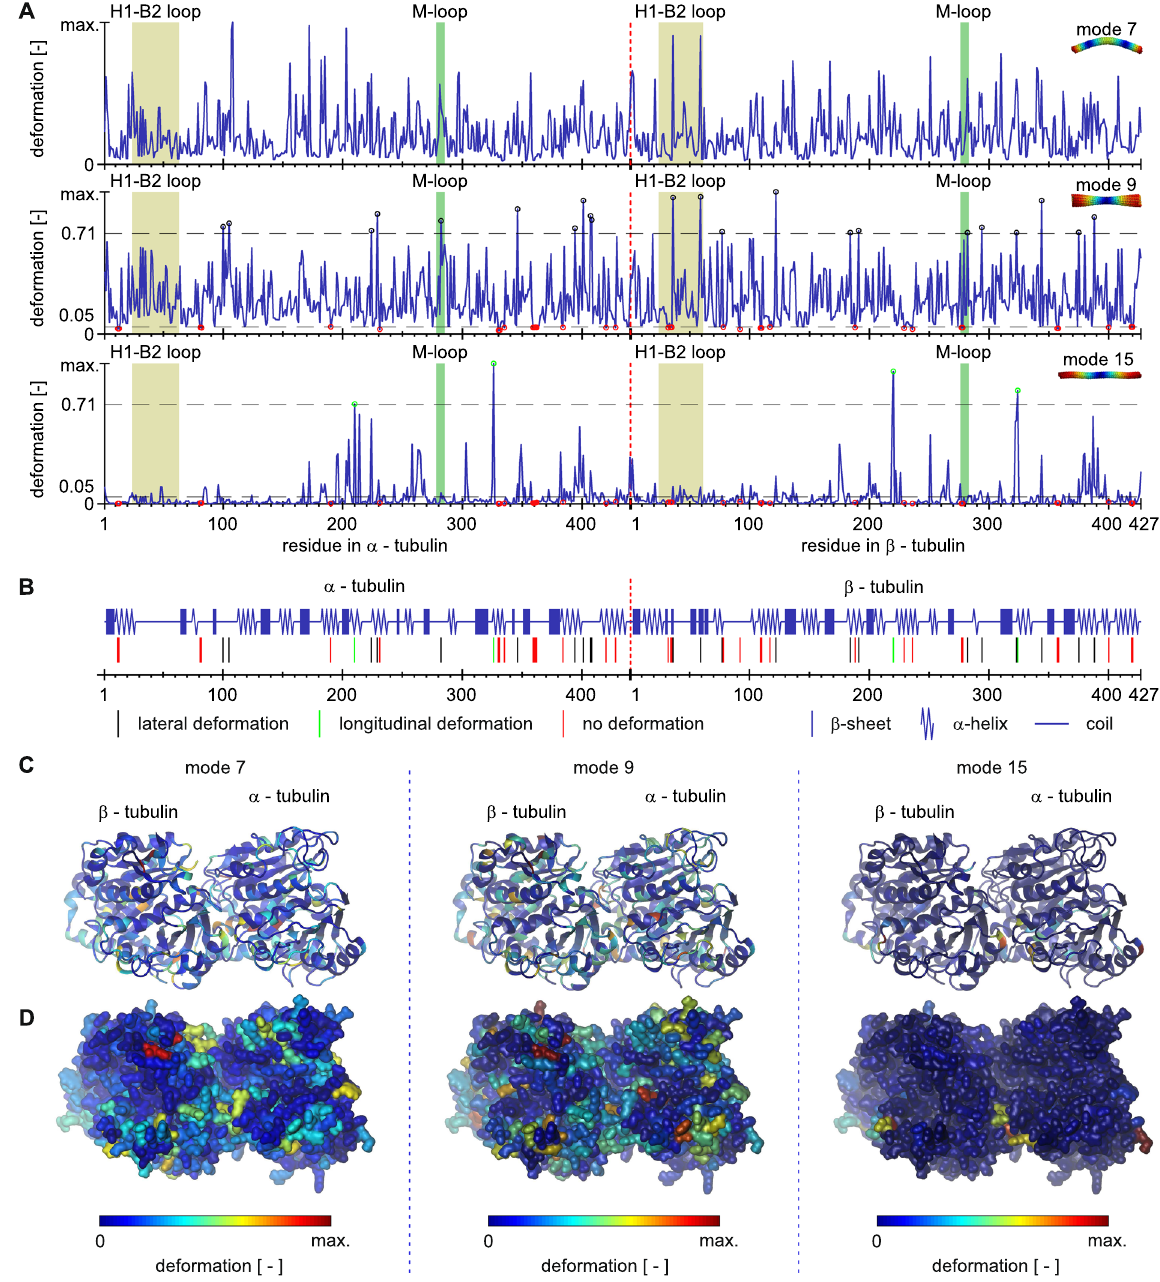
Figure 4. Average absolute value of deformation in tubulin dimers for three principal shapes of normal modes. ( A ) detailed view for the data shown in Fig. 3C. The average absolute deformation along tubulin dimer sequence is shown in blue. ( B ) specific regions of the sequence with substantial deformation are indicated in the secondary structure of tubulin dimer. They are also indicated with circles of respective color in ( A ), together with criterion thresholds. ( C ) average of absolute deformation is mapped on the ribbon model of tertiary structure of tubulin dimer and on tubulin surface model ( D ). Note that all deformation data are normalized to the maximum within respective